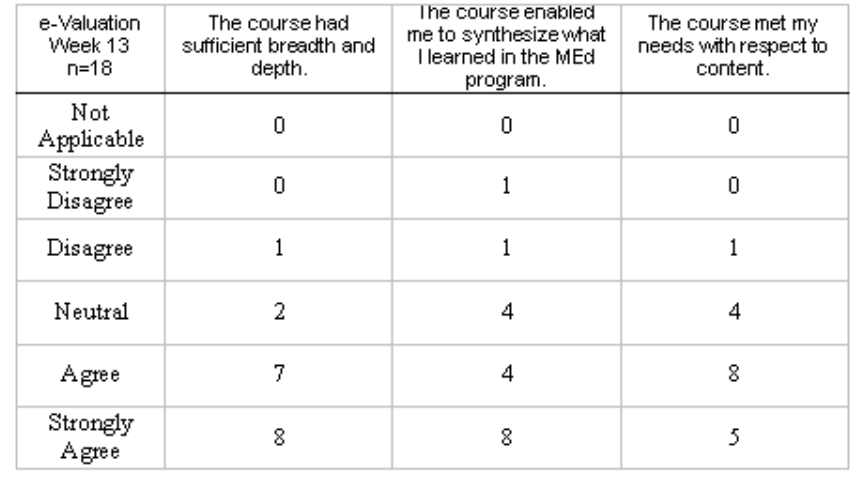
Table 3. Evaluation of the course